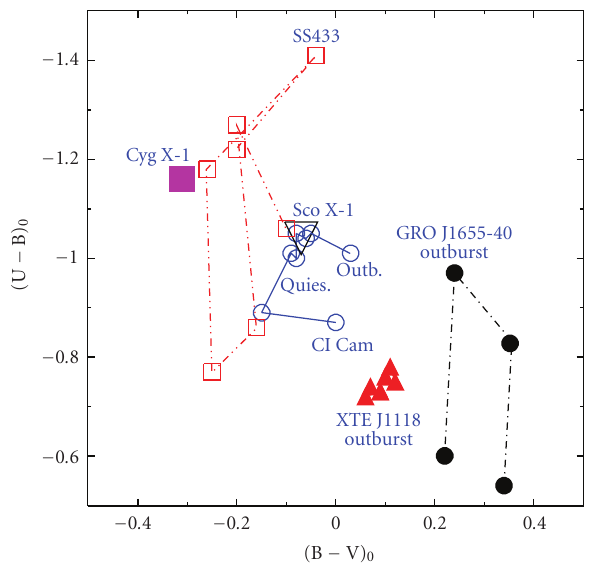
Figure 11: The color-color diagram for microquasars.